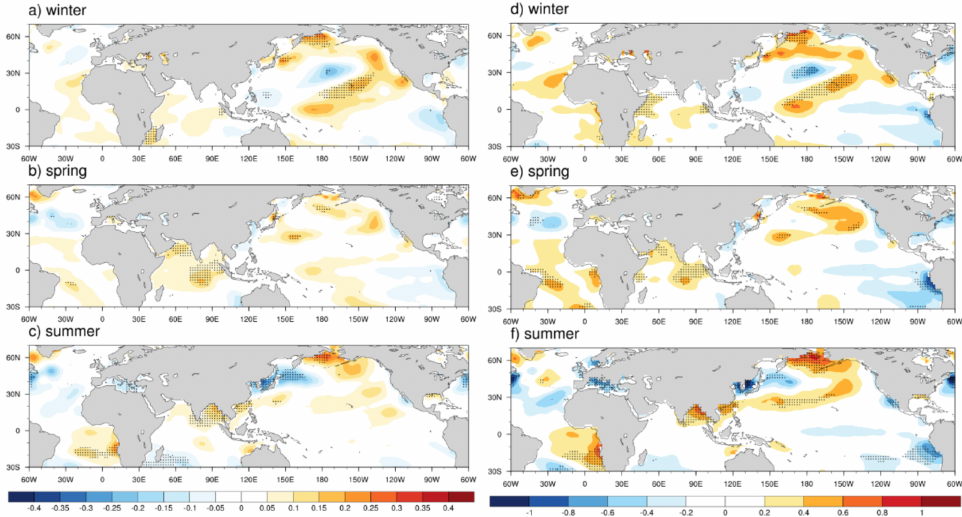
Figure 13. Same as Figure 11 but for PC2. Regression maps are ( a – c ) and difference maps are ( d – f